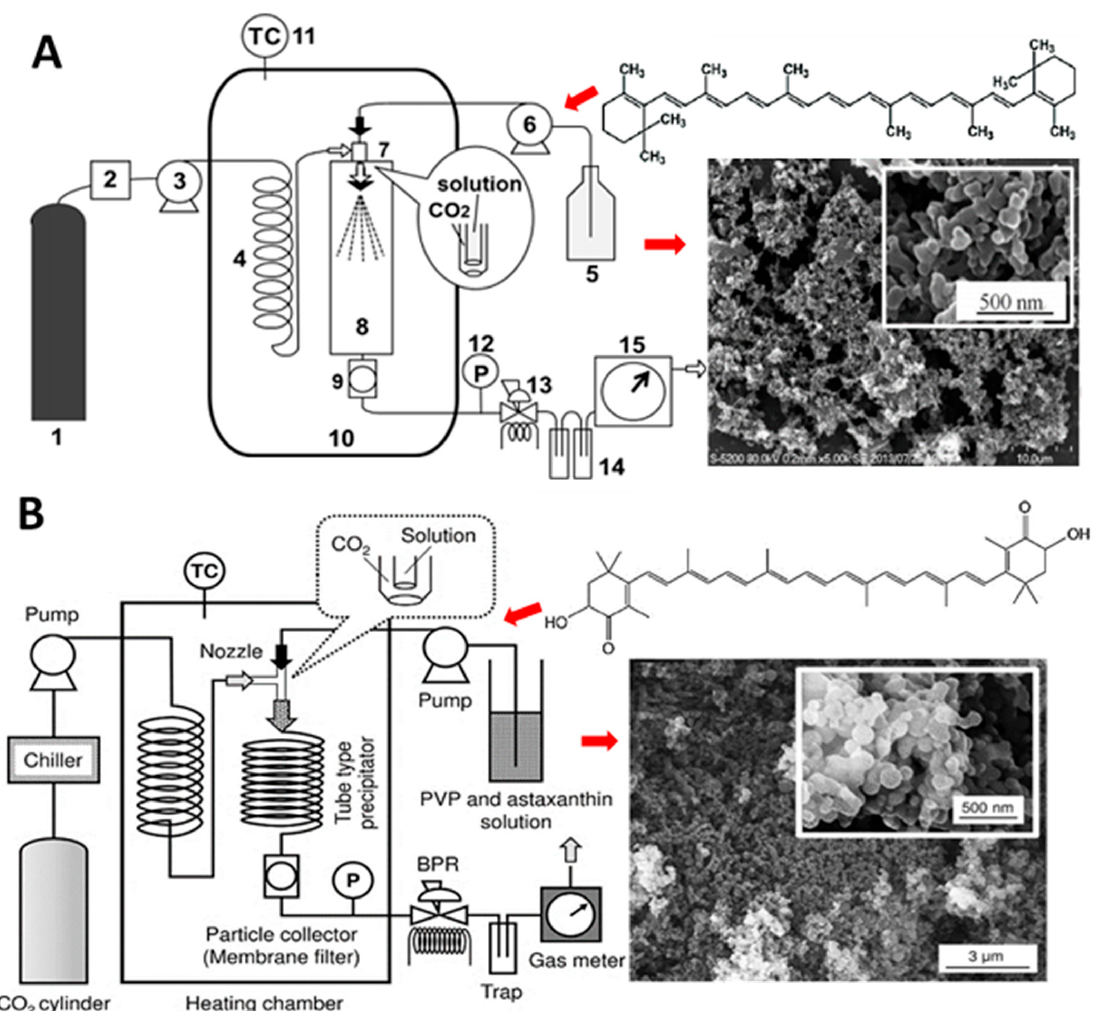
Figure 13. Schematic diagram of the solution enhanced dispersion by supercritical fluid method used for preparation of β -carotene solid lipid nanoparticles ( A ) and astaxanthin solid lipid nanoparticles ( B ) along with each panel showing the respective carotenoid structure and scanning electron micrographic image of solid lipid nanoparticles. In ( A ), steps 1 to 15 represent different processing steps involved in solution enhanced dispersion by supercritical fluid method. Adapted with permission from Kaga, et al. [61] and Nerome, et al.